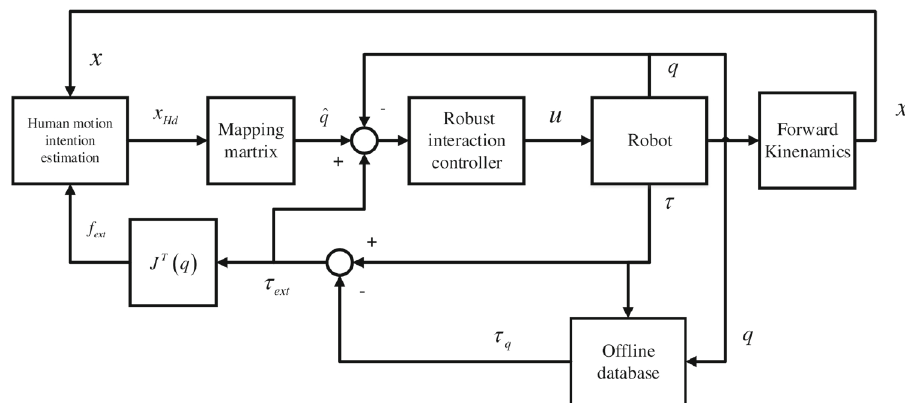
Fig. 2 The whole control